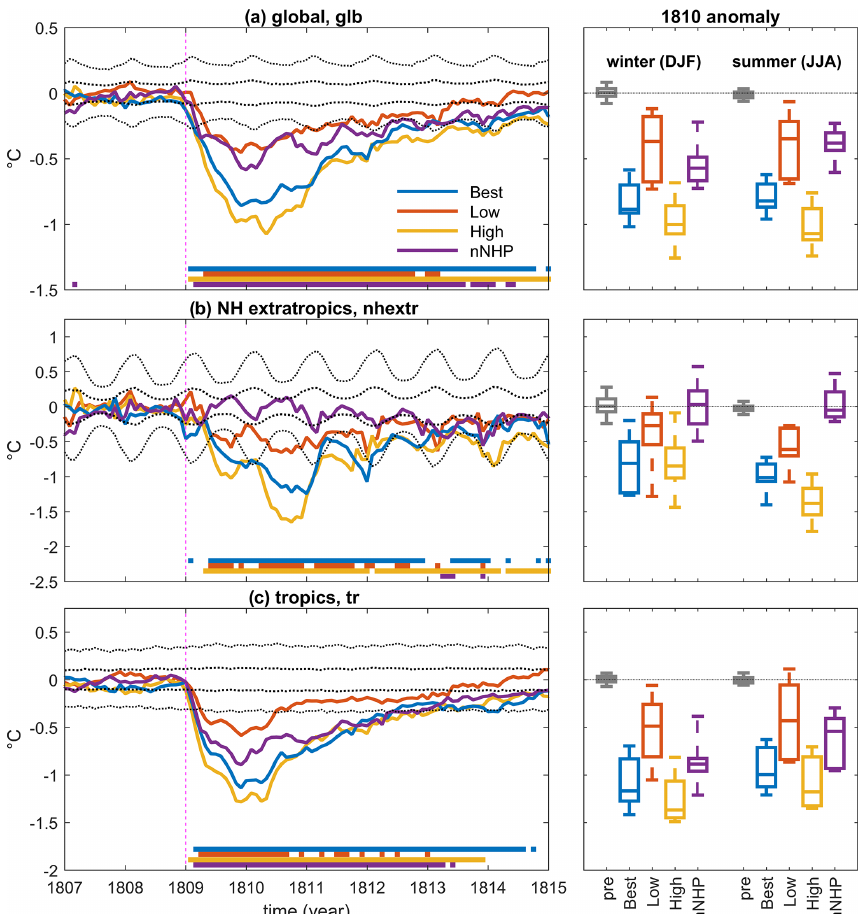
Figure 3. Global, tropical, and extratropical temperature anomalies. Left: simulated ensemble-mean monthly anomalies of (a) global, (b) ex- tratropical Northern Hemisphere, and (c) tropical averages of near-surface air temperature with respect to the pre-eruption (1800–1808) cli- matology. All data are deseasonalized using the respective annual average cycle from the control run. Thick (thin) black dashed lines are the 5th–95th percentile intervals for signal occurrence in the control run for the ensemble mean (ensemble spread). Bottom bars indicate periods when an ensemble member’s monthly mean temperature (color code as for the time series plots) is significantly different ( p = 0 . 05) from the control run according to the Mann–Whitney U test. Right: ensemble distributions (median as well as 25th–75th and 5th–95th percentile ranges) of seasonal mean anomalies for the first post-eruption winter (1809–1810, DJF) and summer (1810, JJA) following the 1809 eruption as well as for the pre-eruption period